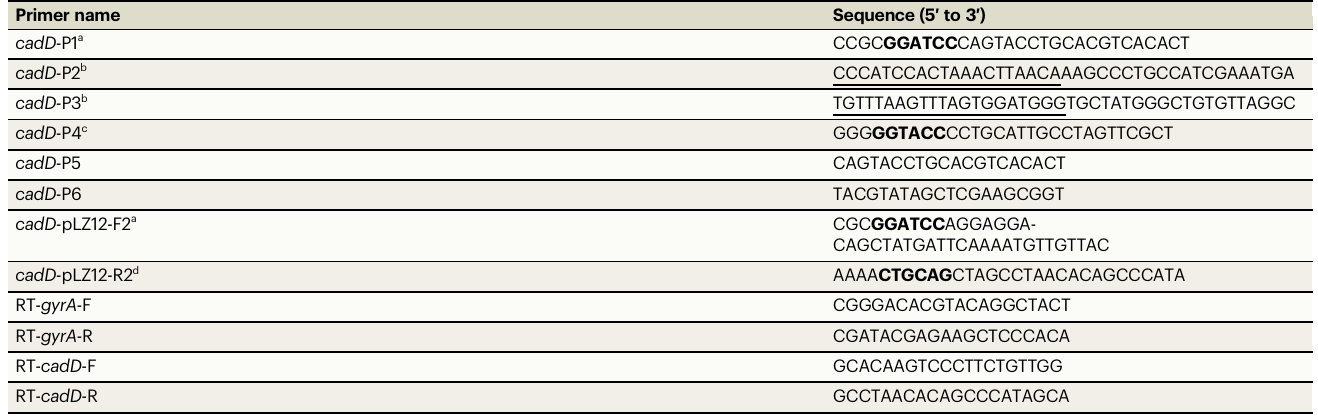
Table 1 | Oligonucleotide primers used in this